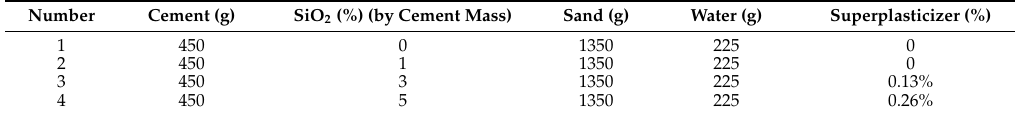
Table 6. Mix proportions of the